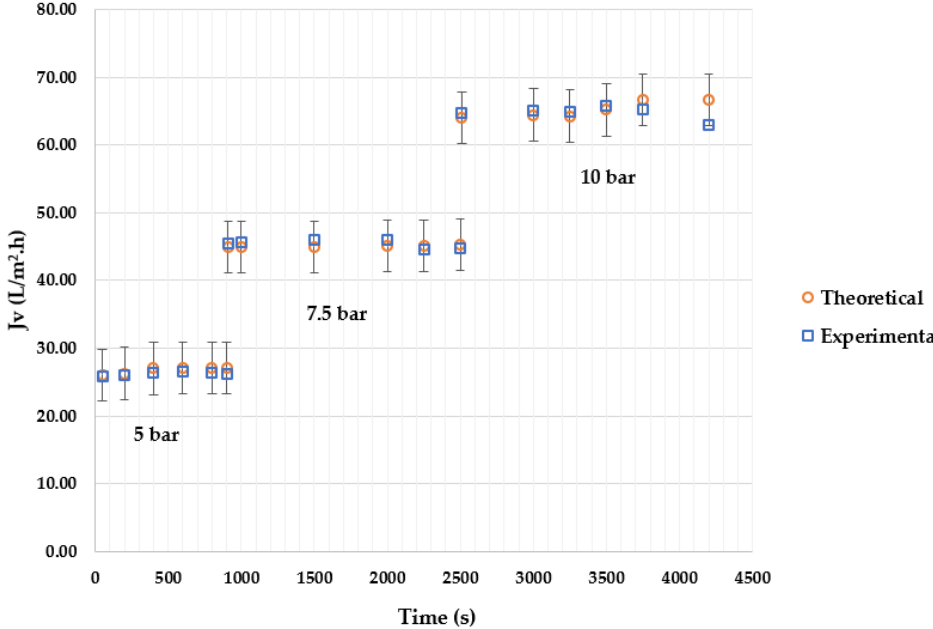
Figure 17. Theoretical vs. experimental Pb comparison: maximum error at high concentration.